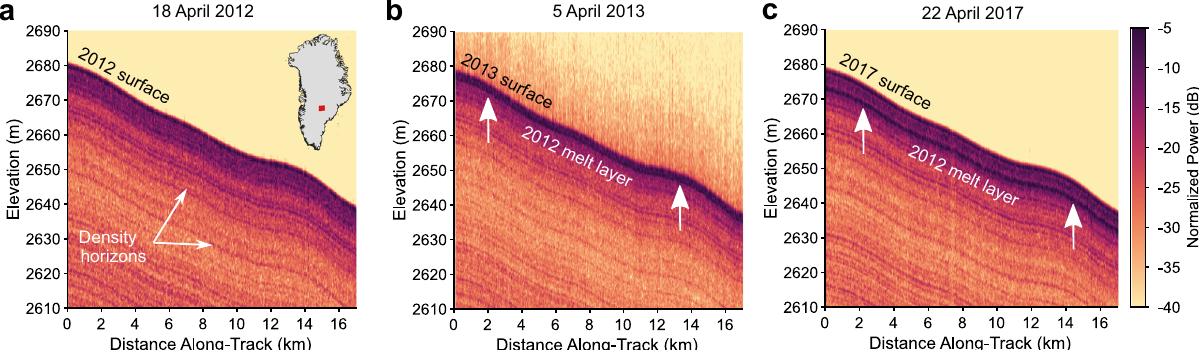
Fig. 1 Representative radargrams from southwest Greenland showing the 2012 melt layer. These data highlight the initial development and persistence of the 2012 melt layer in a April 2012, b April 2013, and c April 2017. The location of these radargrams is shown by the red line in the inset map in a . The color scale represents received radar power, with dark colors indicative of strong returns from areas of high density contrast within the fi